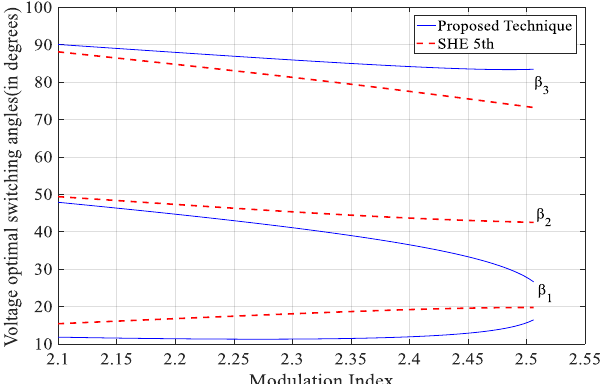
Figure 10. Curve showing variation between the estimated switching angles and modulation index for SHE of 5th-order harmonics and the proposed technique.